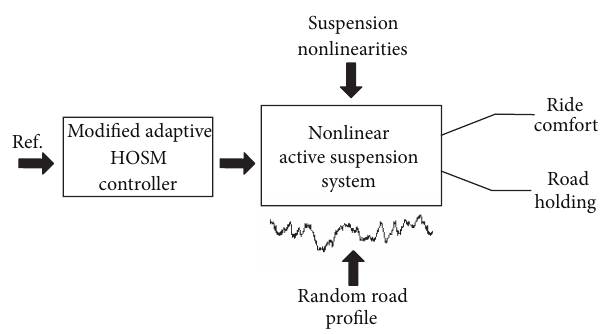
Figure 2: The block representation of the proposed control.